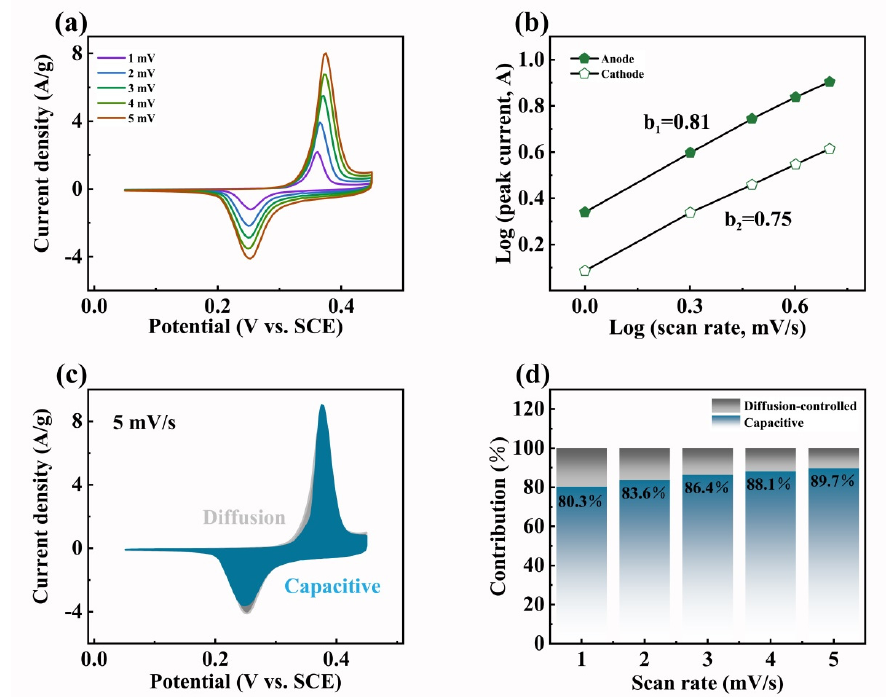
Figure 7. Analysis of the charge − storage mechanism of the NMH − 2. ( a ) CV curves, ( b ) plot for diffusive and capacitive current contributions, ( c ) the contributions of capacitive − and diffusion − controlled processes at 5 mV/s, and ( d ) the fractions of capacitive and diffusion − controlled processes at different scan rates.